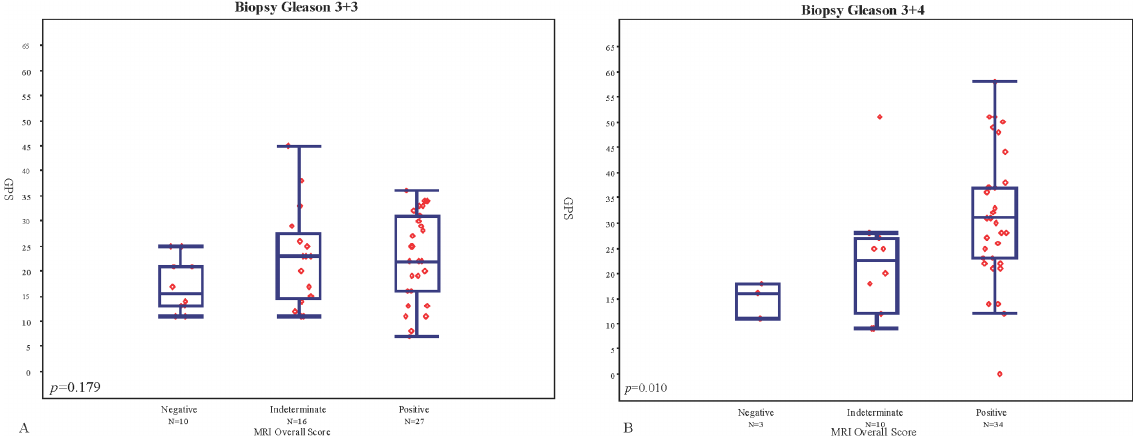
Fig 2. A. Distributionof GPS results by MRI findings amongmen with biopsy Gleason grade 3+3 and B. Among patients with Gleason grade